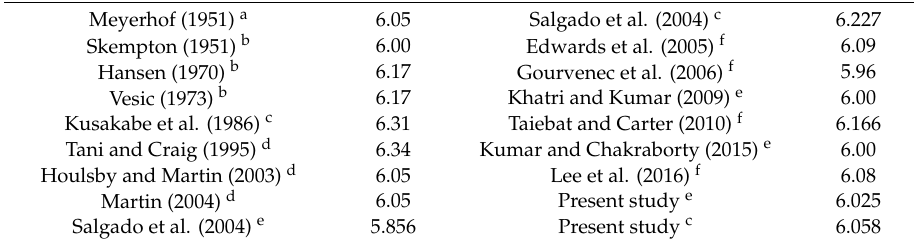
Table1. Comparisonofbearingcapacityfactor( N c